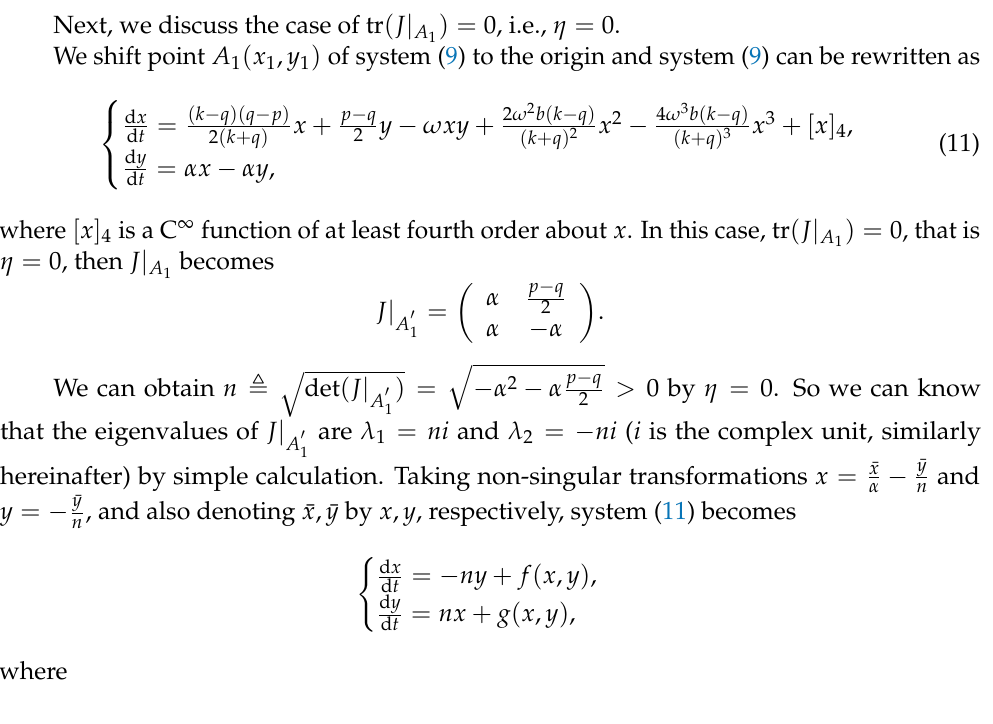
Figure 2. It shows that the solution of system (9) is uniformly bounded in Ω